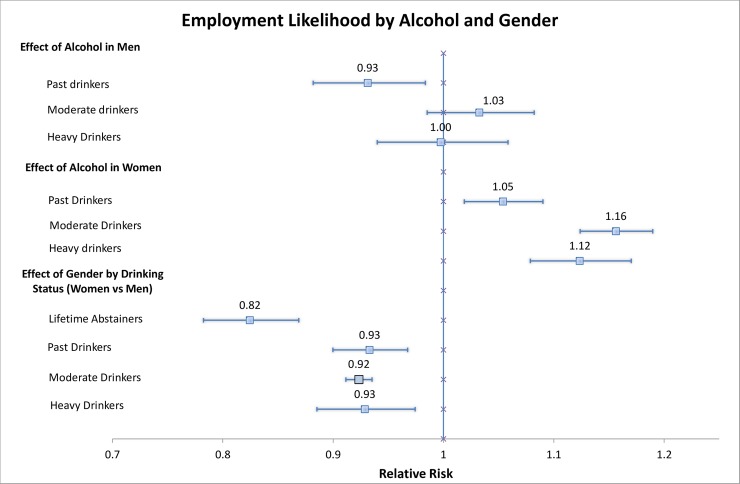
Employment Likelihood due to past drinking status.Note: Models adjusted for marital status, education, smoking, age, gender, country level fixed effects, and number of social events attended. p-value for gender effect modification: p<0.0001. The forest plot was created based on a template by [30].